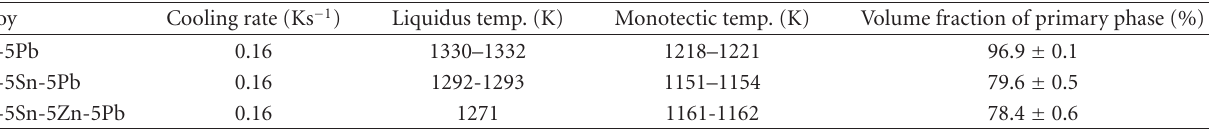
Table 2: Liquidus and monotectic temperatures for the investigated alloys as determined from the cooling curves.